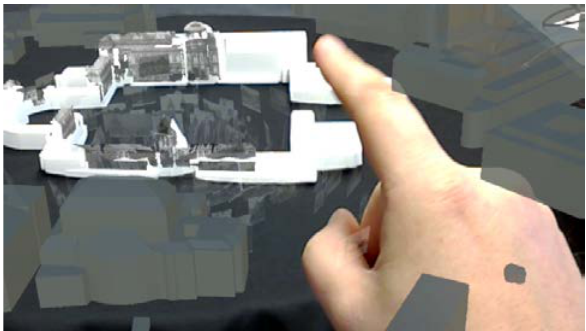
Figure 14. HMD-based AR using